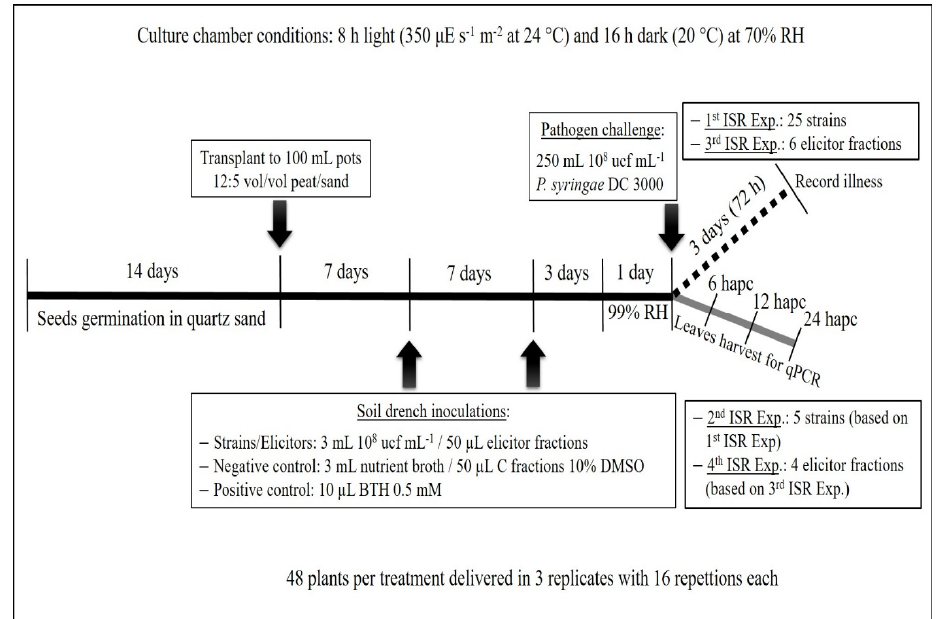
Figure 8. Induced systemic resistance (ISR) experiments represented as a timeline. The black continuous line represents the part of the experimental design common to all ISR experiments; the black dashed line represents the last part of ISR experiments to assess protection against the pathogen (first and third experiments) and the grey continuous line represents the last part of ISR experiments to carry out differential gene expression analyses by qPCR (second and fourth experiments).